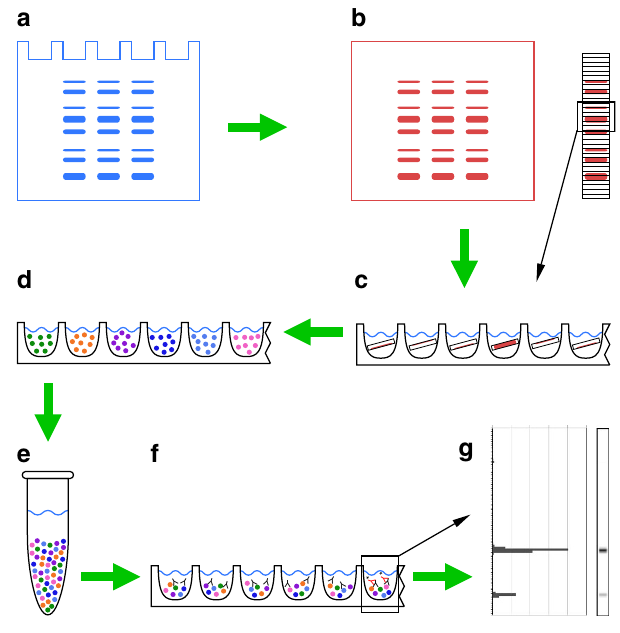
Figure 1 | Bead-based western blot (DigiWest) workflow. ( a ) Protein separation by gel electrophoresis, usually SDS-PAGE. ( b ) Blotting of proteins to membrane and biotinylation of immobilized proteins directly on the membrane. ( c ) The cutting of sample lanes into 96 stripes to generate 96 molecular weight fractions immobilized on the membrane; elution of the proteins in 96-well plates. ( d ) Loading of biotinylated proteins onto 96 distinct Neutravidin-coated magnetic Luminex bead-sets. ( e ) Pooling into bead pools and reconstitution of the initial sample lane. ( f ) Immunoassay: aliquots of the generated bead pool ( o 0.5%) are incubated with western blot antibodies overnight before PE-labelled secondary antibodies are added for signal generation. ( g ) Readout using a Luminex instrument, reconstitution of the initial lane and data